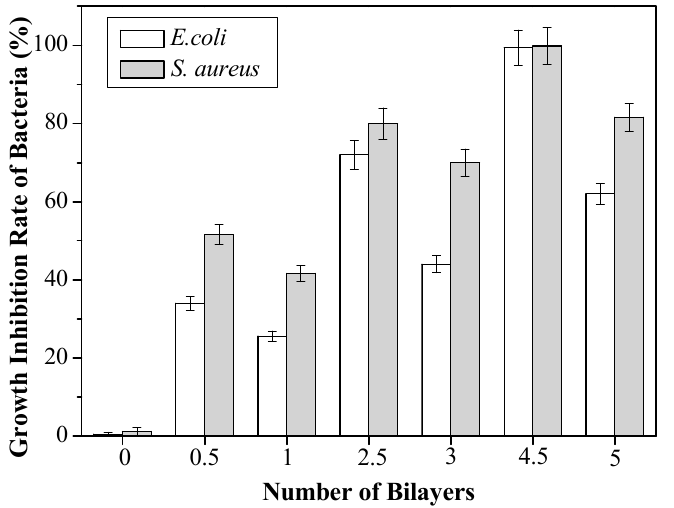
Figure 3. The bacteria growth inhibition rate of paper modified with ε -PL/CMC multilayers having different bilayer numbers.